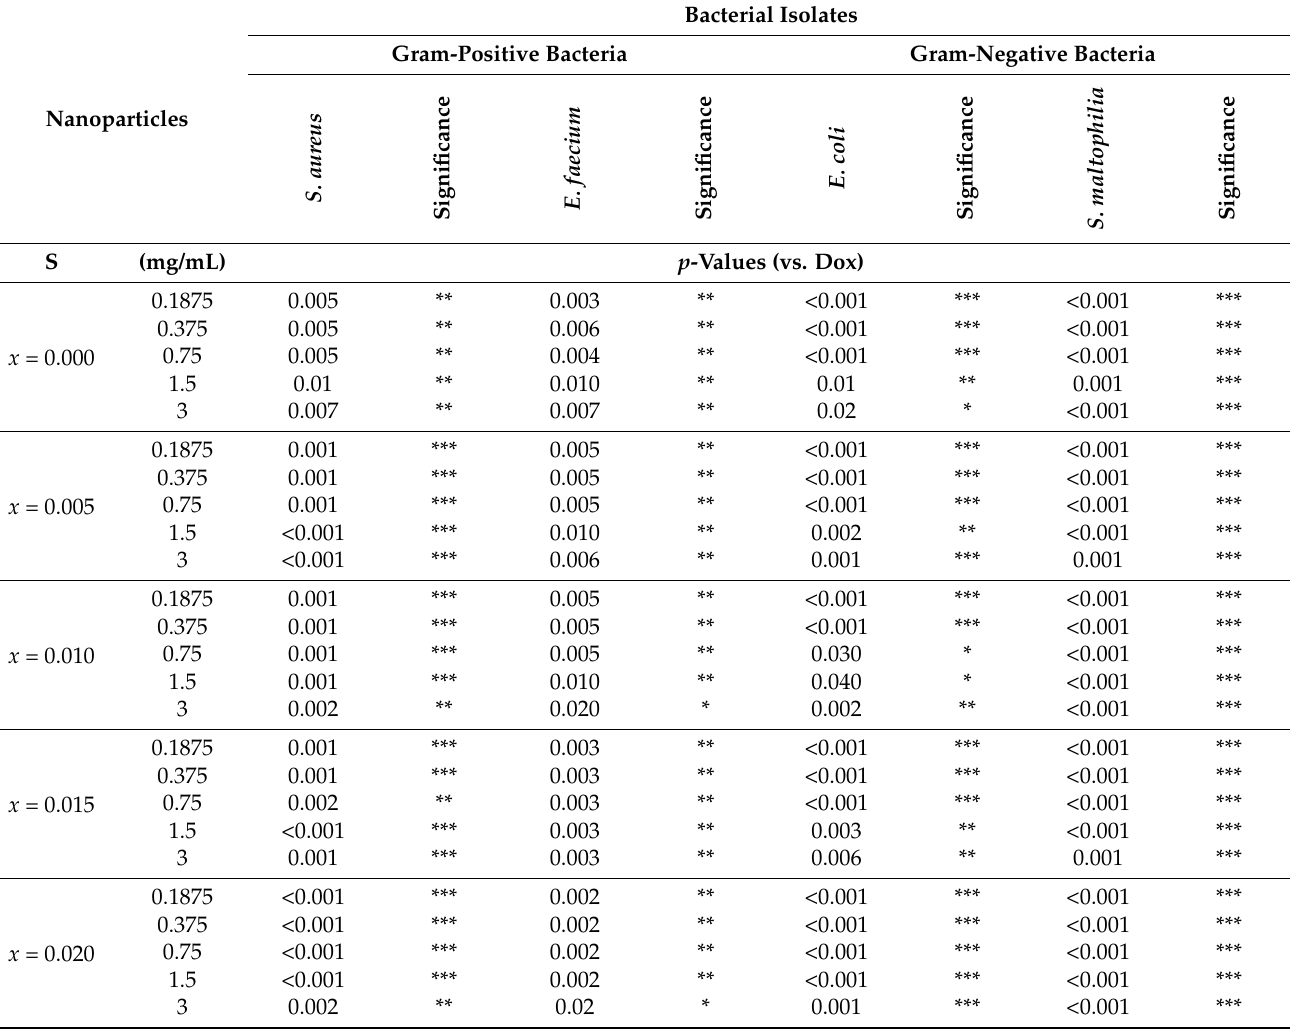
Table A1. Calculated p -value and significance levels of the agar well diffusion results of the undoped and Mg-doped CuO